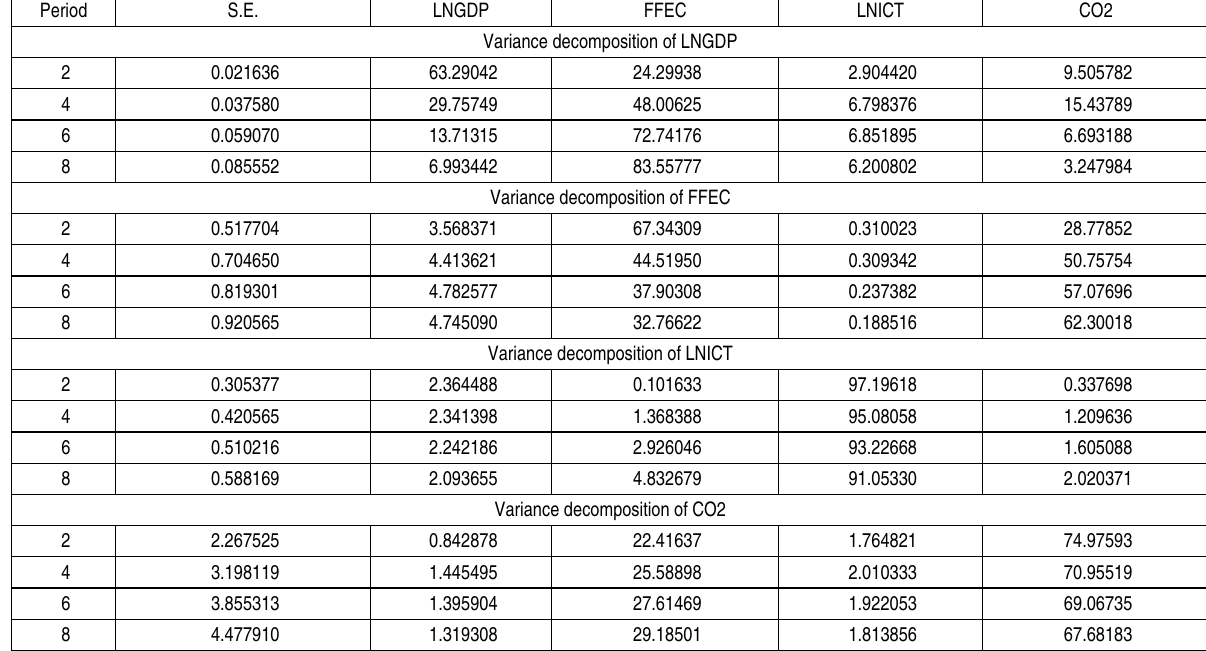
Table 5. Variance decomposition: Cholesky ordering: LNGDP FFEC LNICT CO2